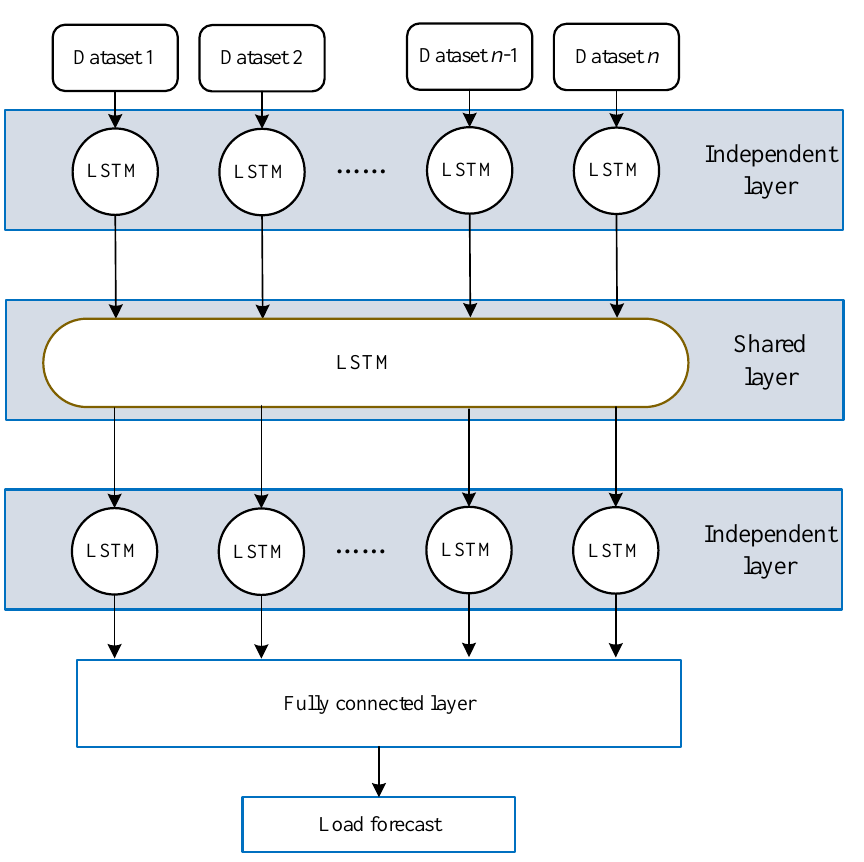
Figure 2. Schematic diagram of WSLSTM prediction model structure.